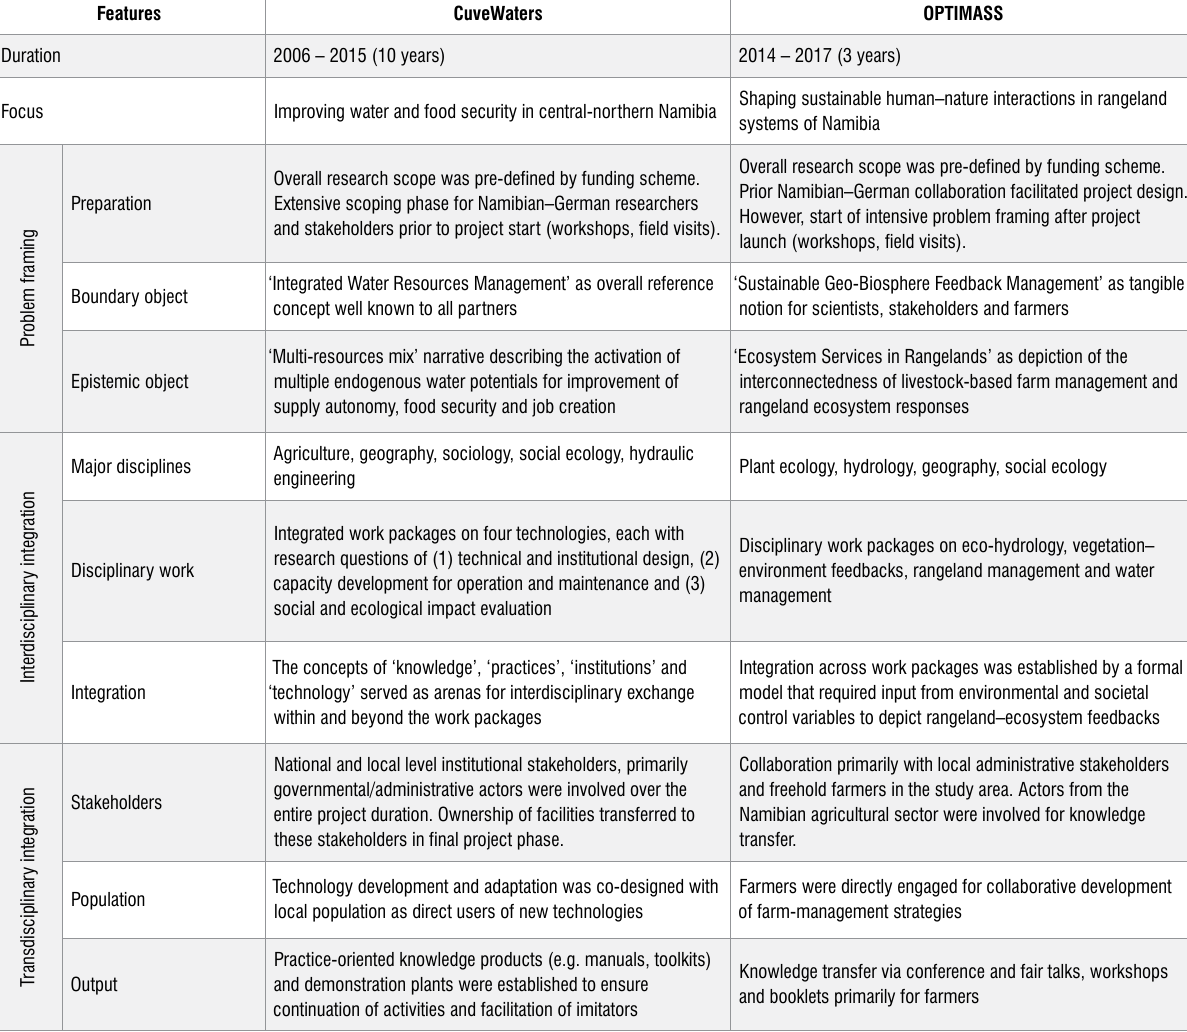
Comparative overview on key features of the idealised transdisciplinary research stages